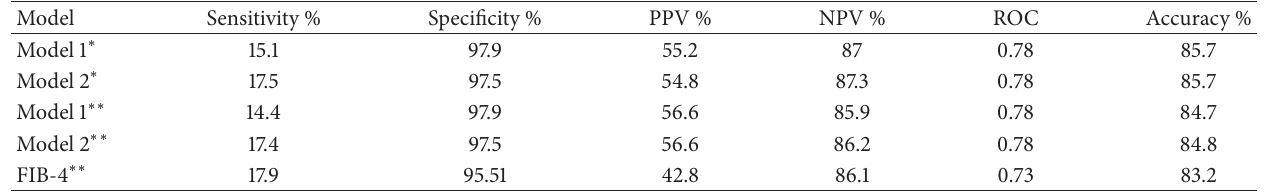
Table 3: Accuracy and Roc analysis of model 1, model 2, and FIB-4 for predicting advanced fibrosis with criteria value zero.